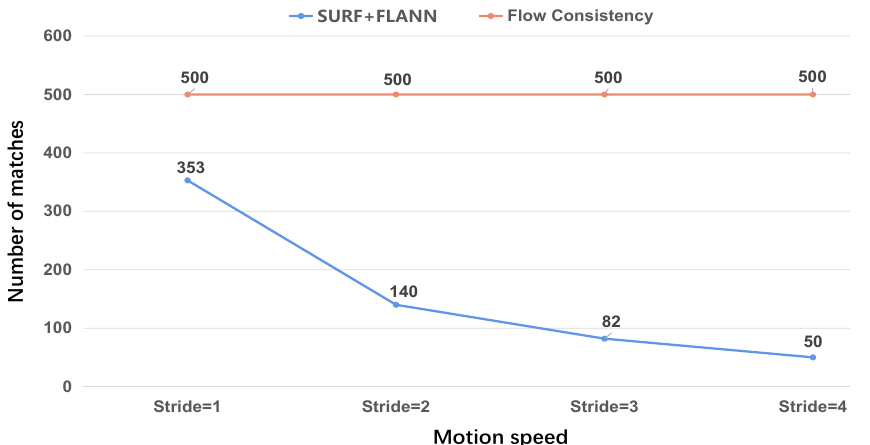
Figure 6. As the motion increases, the number of matches found by SURF+FLANN decreases from 353 to 50.